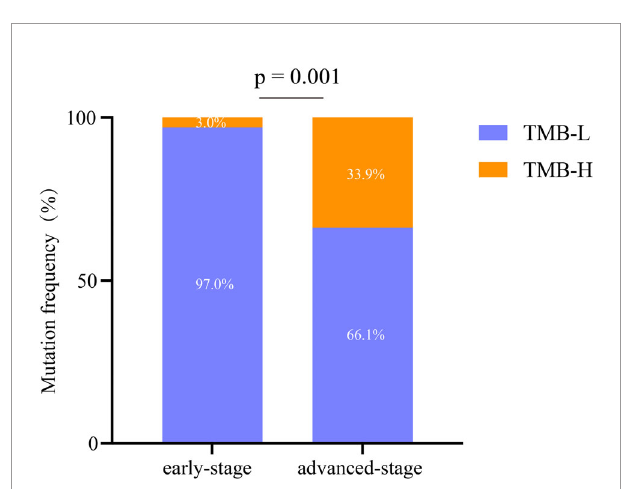
FIGURE 4 | Analysis of the characteristics of immunotherapy biomarkers in early stage and advanced-stage NSCLCs. TMB-H, high tumor mutation burden; TMB-L, low tumor mutation burden.